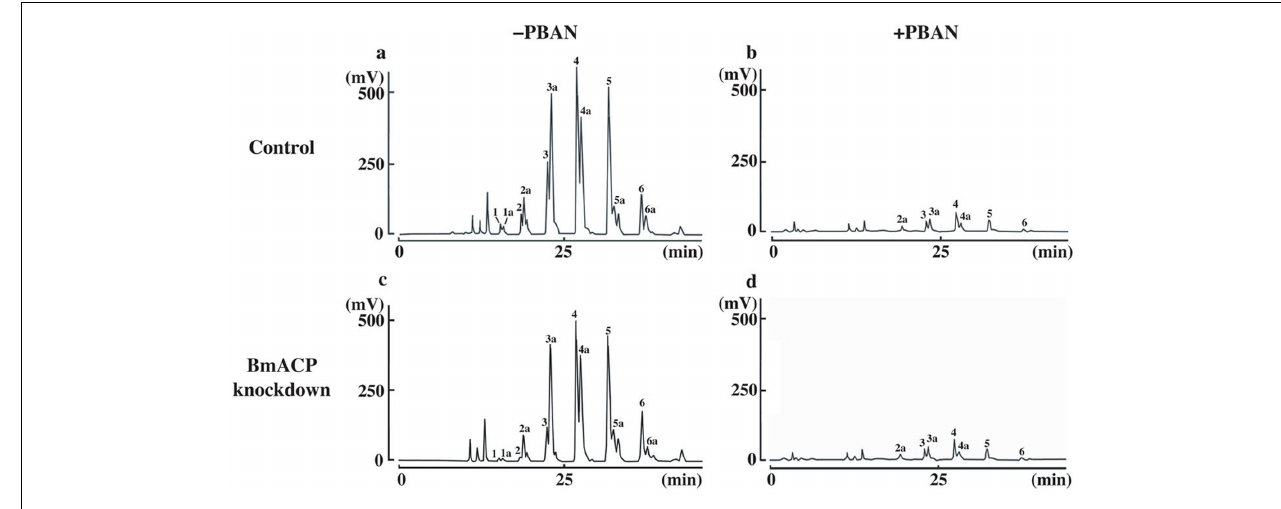
FIGURE 7 | Separation of PG-derivedTAG components. PG cells were dissected from 1-day-old decapitated female moths previously injected with either DEPC-treated H 2 O (control) or 10 μ g BmACP dsRNA (BmACP knockdown) shortly after pupation. After eclosion, females were decapitated within 3h of emergence, maintained at 25˚C for 24h, and then injected with PBS alone ( − PBAN) or 5pmol B. mori PBAN ( + PBAN).